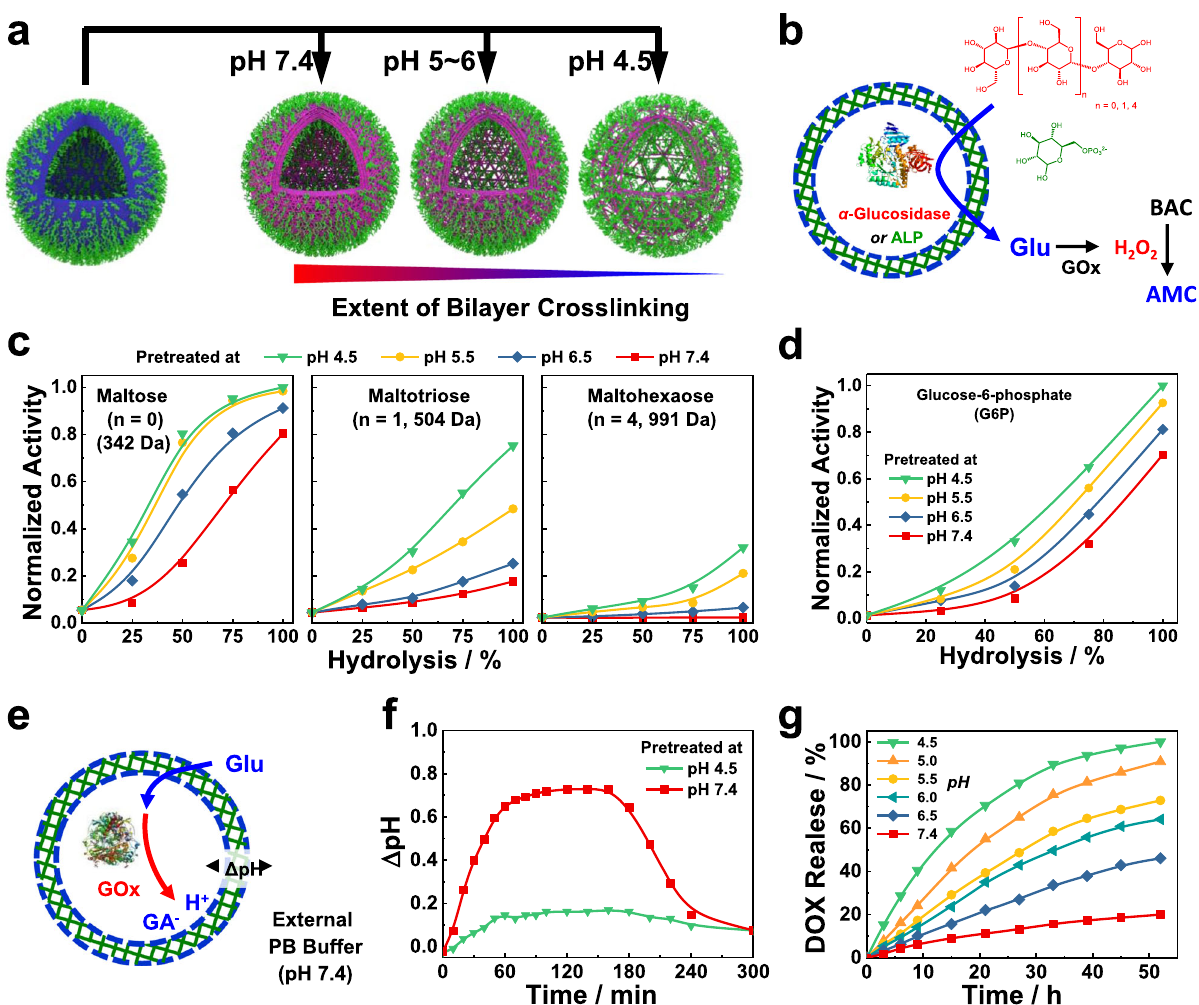
Fig. 3 pH-regulated polymersome bilayer permselectivity. a Schematics of modulating the extent of bilayer crosslinking and corresponding mesh sizes via pH adjustment. b Schematics of assaying bilayer permeability by coupling enzymatic reactions inside aqueous interiors of polymersomes with externally added substrates of varying molecular sizes and charges. The aqueous lumen is loaded with either α -glucosidase or alkaline phosphatase (ALP). c , d Variation of normalized activities (i.e., initial rates of H 2 O 2 -actuated fl uorogenic transformation of BAC into AMC) as a function of hydrolysis extents of imine linkages in c α - glucosidase-loaded and d ALP-loaded BPN 23 polymersomes (0.2g/L); the polymersome dispersions were pretreated at varying pH to reach speci fi ed extents of imine hydrolysis and then adjusted to pH 7.4 using PB buffer. Into the external buffer media, GOx (1.0mg/L), BAC (50 μ M), and one of the corresponding enzymatic substrates including maltose, maltotriose, maltohexose, and glucose 6-phosphate (G6P) were added, the evolution of fl uorogenic AMC emission was then monitored for 30min. e Schematics of the construction of transient acidic milieu inside the aqueous lumen of BPN 23 polymersomes (0.2g/L) encapsulating GOx using externally added glucose as substrate. f Evolution of pH discrepancy, Δ pH, between the aqueous lumen and external media (PB buffer; pH 7.4) upon addition of 2mM glucose. GOx-loaded BPN 23 polymersomes (0.2g/L) were pretreated at pH 4.5 for 10h and pH 7.4 for 100h, respectively, and then adjusted back to pH 7.4 using PB buffer (30mM). g Release pro fi les of DOX from drug-loaded BPN 23 polymersomes (0.2g/L) upon incubation at varying